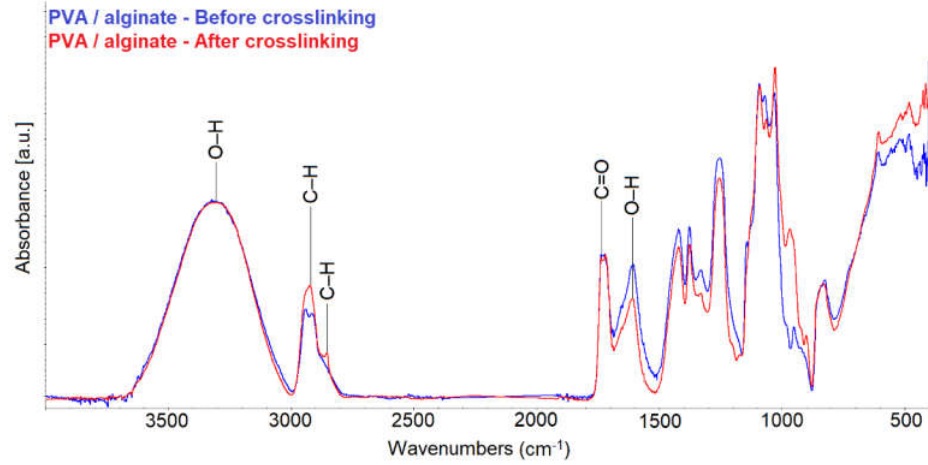
Figure 5. FTIR spectra of the PVA/alginate fiber layers before and after crosslinking. The measured spectra show that there was a change in the structure of the PVA/alginate layer after crosslinking. Due to crosslinking, there was no change in the absorbance for